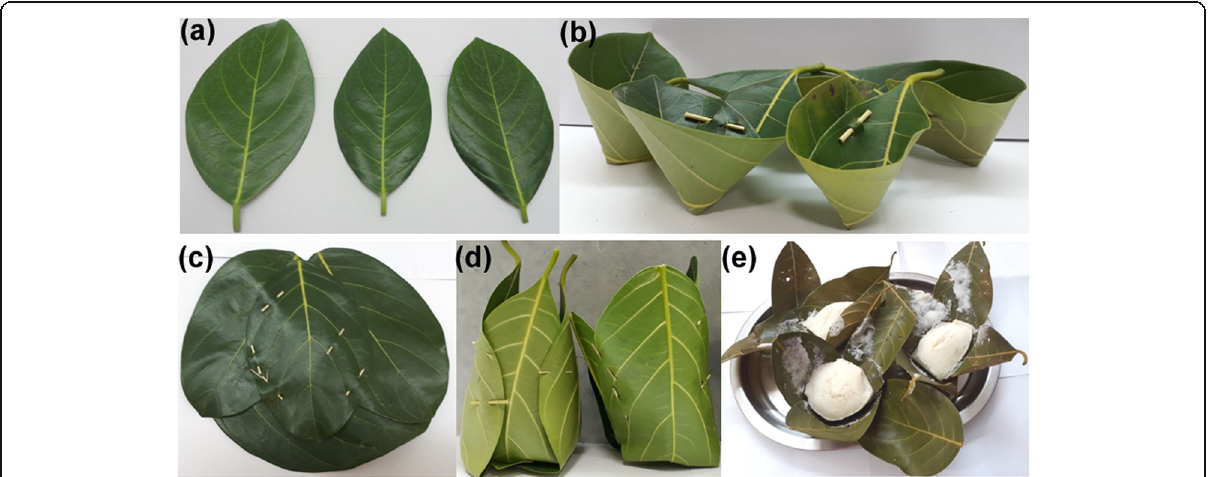
Fig. 5 a The leaves of jackfruit, A. heterophyllus , ( b ) the cones, plavila kori made with the jackfruit leaves are used as spoons for drinking kanji, ( c ) the hand stitched dining plate made from the leaves of jackfruit, ( d ) the hand woven jackfruit leaf baskets, panasa buttalu and ( e ) the steam cooked Andhra pottikkalu in leaf baskets.